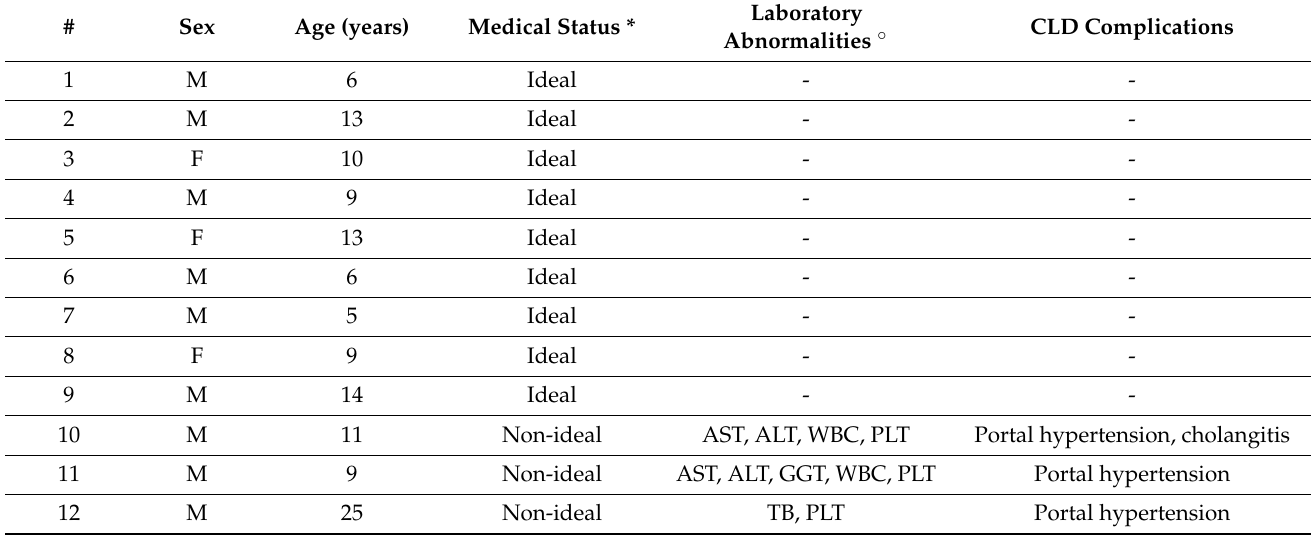
Table 1. Clinical results of stable patients (group